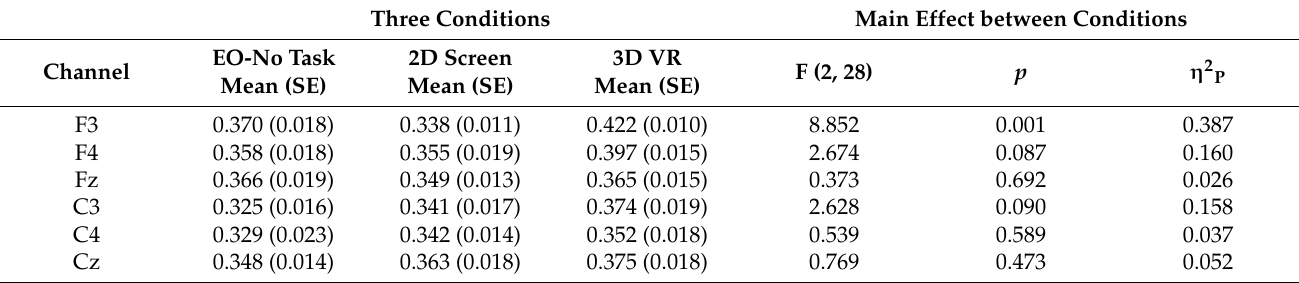
Table 2. Relative EEG delta power for the three conditions EO-no task, 2D screen and 3D